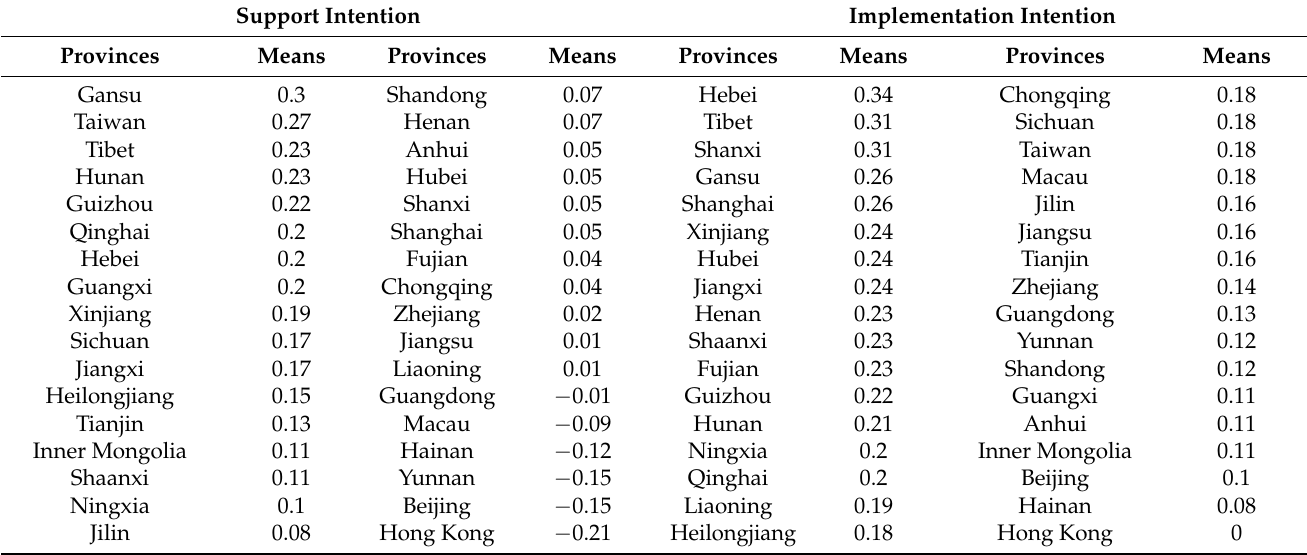
Table 1. Means of support intention and implementation intention after release-type